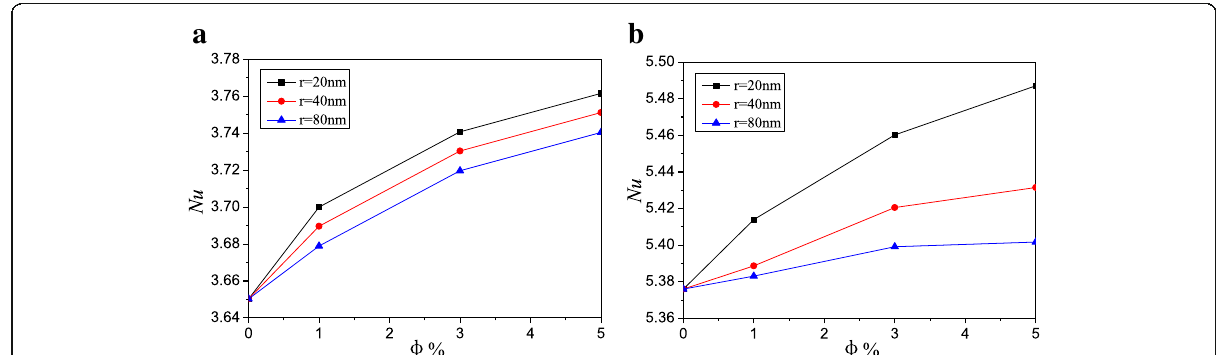
Fig. 8 Average Nusselt numbers with different nanoparticle radiuses, A =4:1. Average Nusselt numbers of Ag-Ga nanofluid with different nanoparticle radiuses along with the left hot wall, A =4:1. a Ra =10 3 . b Ra =10